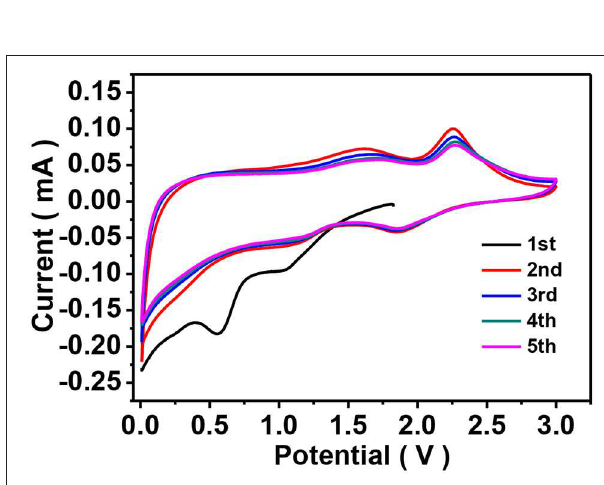
FIGURE 5 | CV curves of the ZIF-67-C@MoS 2 composite as LIB anodes in the voltage range of 0.01–3.0V at a scan rate of 0.1mV s − 1